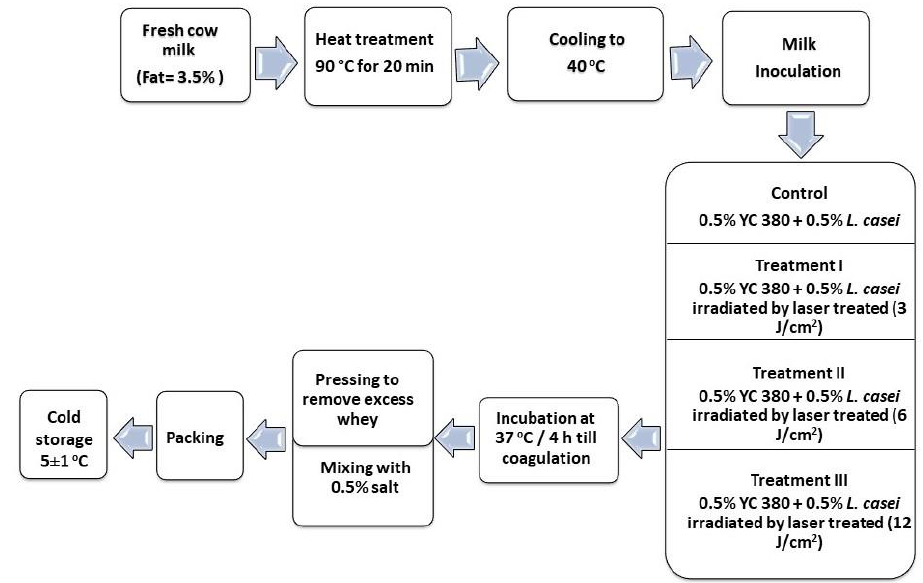
Figure 2. Graphical diagram for the manufacture of